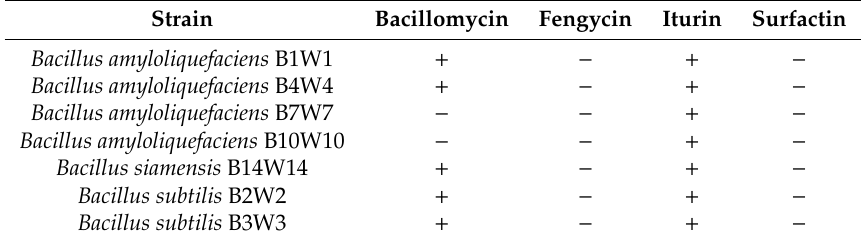
Table 4. Detection of genes involved in the production of lipopeptides in bacterial antagonists. Strain Bacillomycin